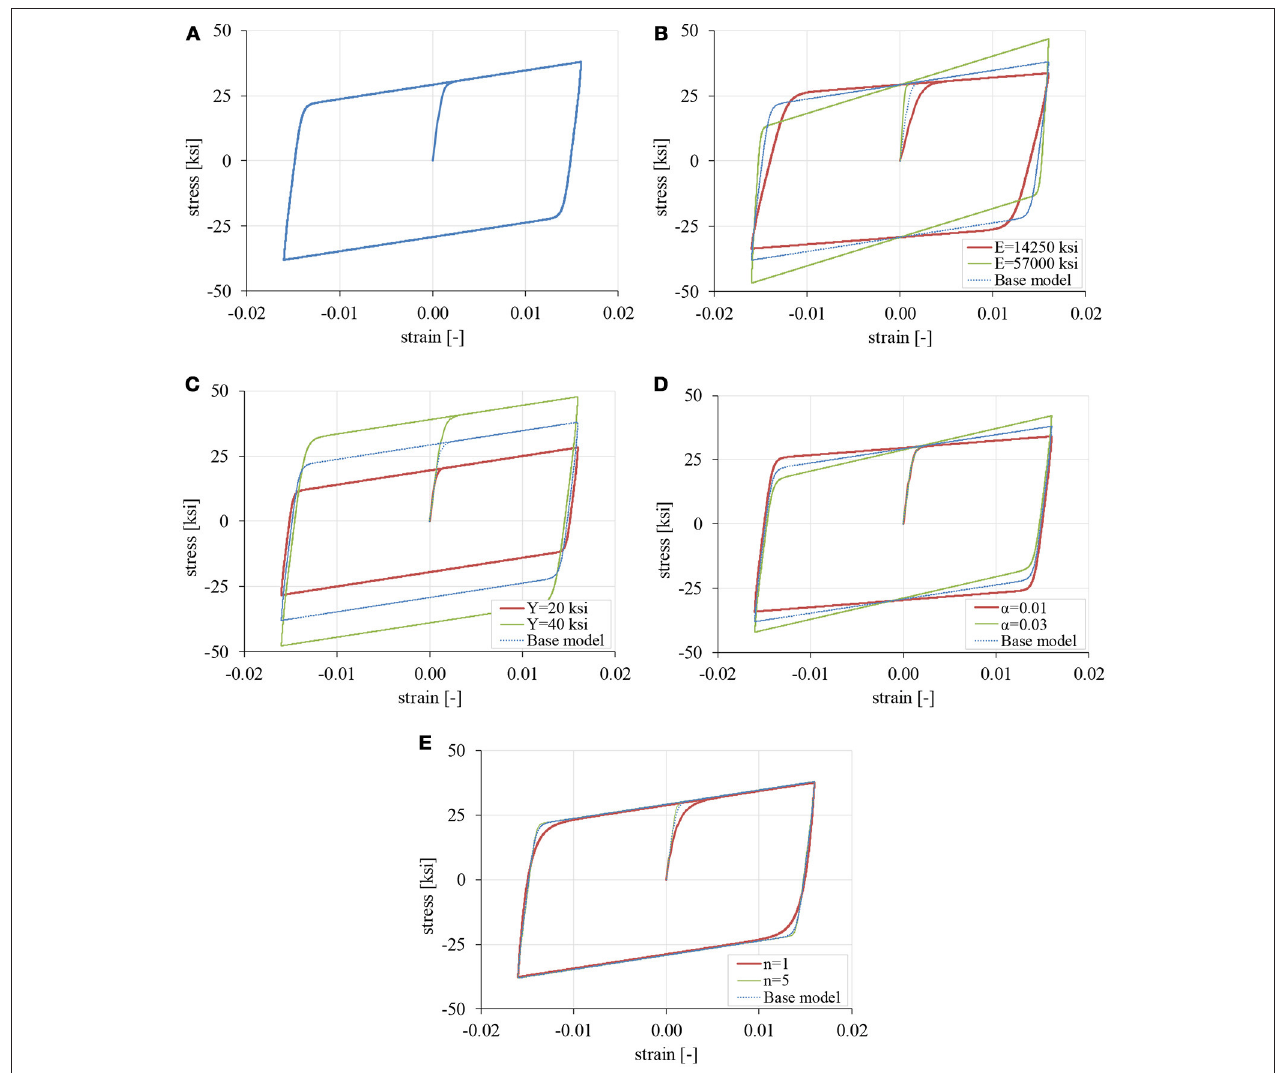
0) with the Graesser-Cozzarelli model, (A) base model with E =